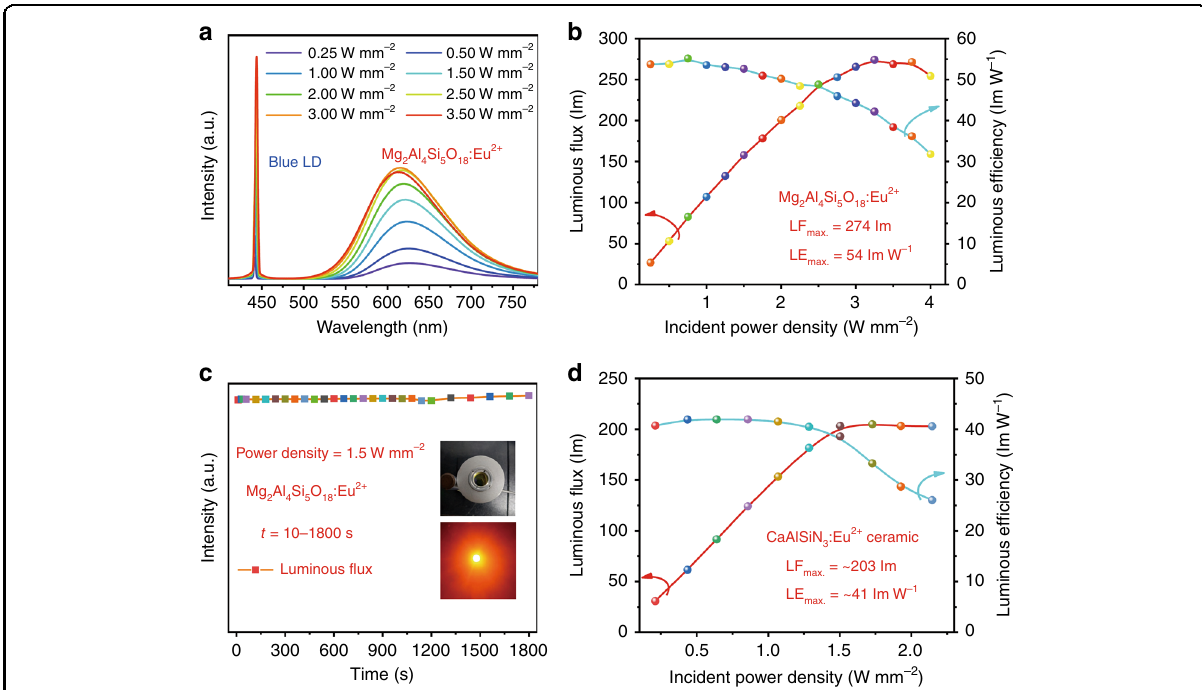
Fig. 5 Photoelectric properties of the LD driven red-emitting device constructed by using Mg 2 Al 4 Si 5 O 18 :Eu 2 + phosphor. The power density- dependent a luminescent spectra b luminous fl ux and luminous ef fi ciency of Mg 2 Al 4 Si 5 O 18 :Eu 2 + composite under the excitation of 445 nm blue laser. c Time-dependent luminous fl ux of the composite at a fi xed incident power density of 1.5 W mm − 2 , the inset show the photograph of red LD device. d The incident power density-dependent luminous fl ux and luminous ef fi ciency of the CaAlSiN 3 :Eu 2 + ceramic